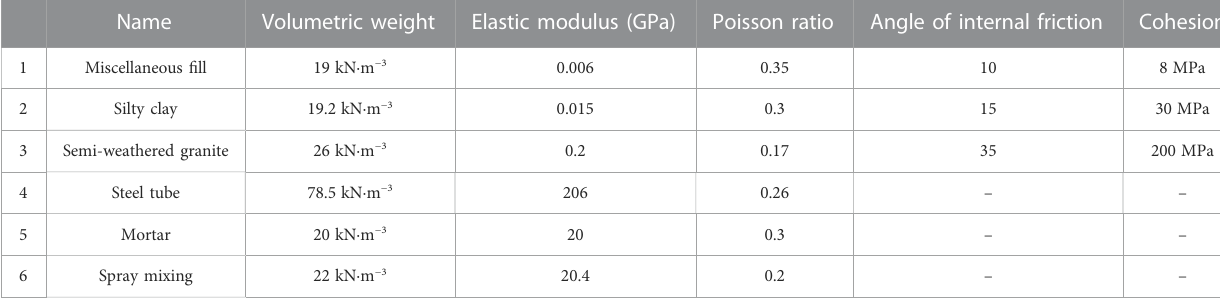
TABLE 1 Building materials and station support